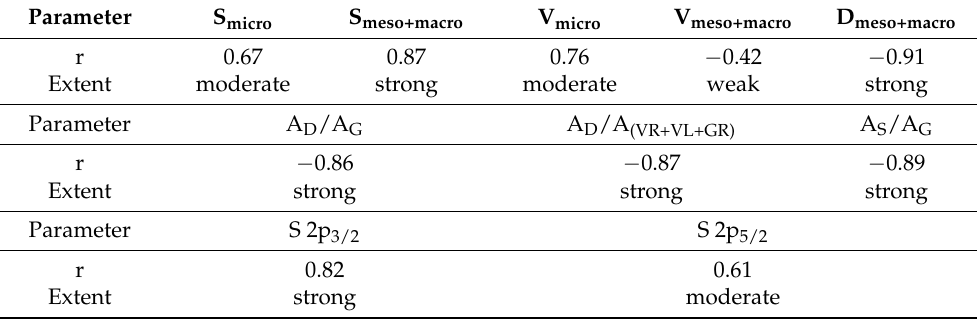
Table 3. Effects of structures on specific capacitance during effective activation